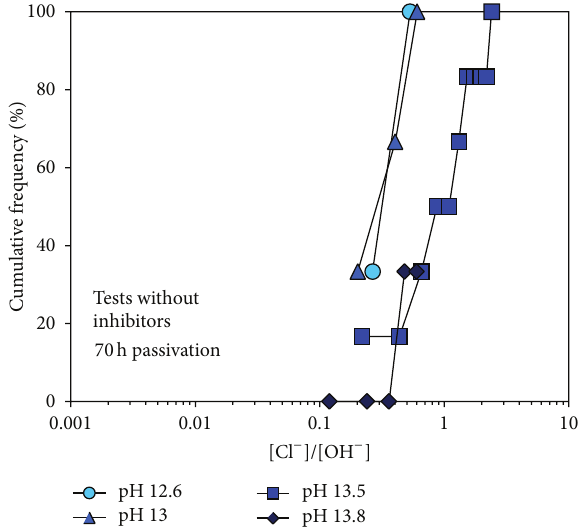
Figure 3: Cumulative frequency of corroded specimens at different pH as a function of chloride-hydroxyl ratio.